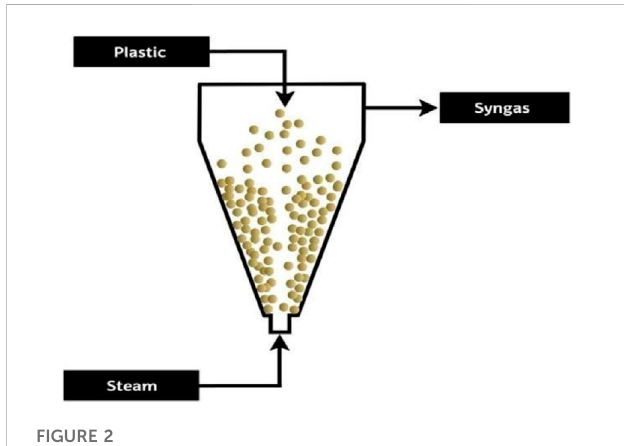
FIGURE 2 Spouted conical bed gasi fi